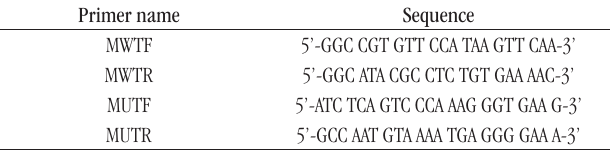
taBLE 1 − Sequence of primers used in PCR for genotyping